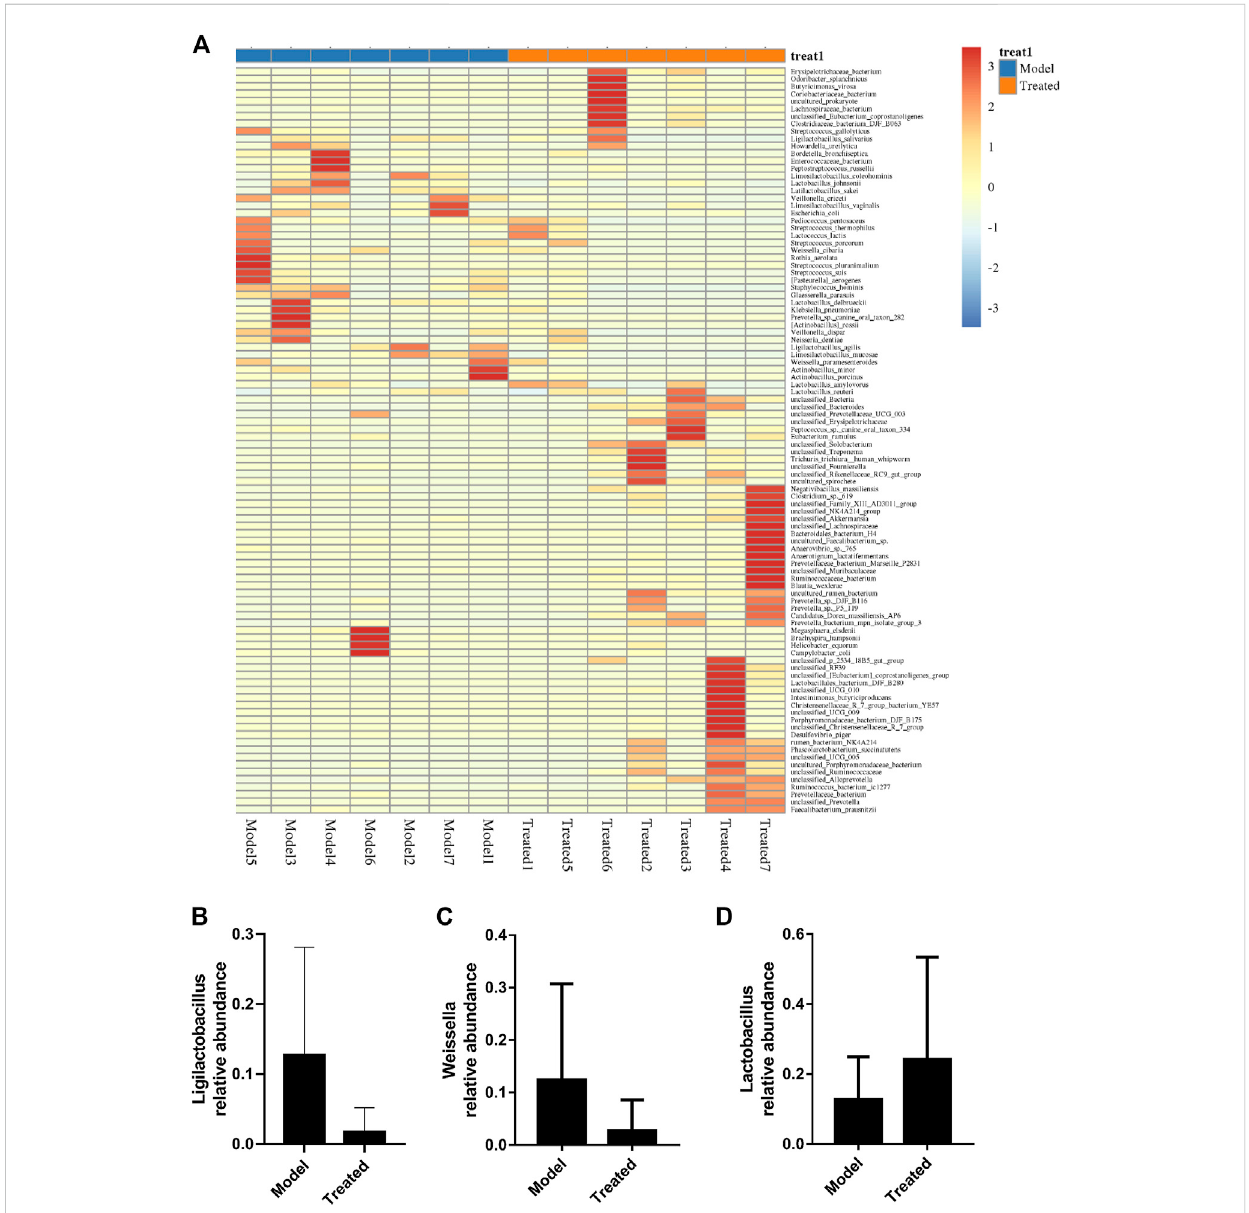
FIGURE 11 Effects of HJ on intestinal microbiota and key microbiota at the species level. (A) Species composition heat map at the genus level for species clustering. The higher the yellow degree was, the lower the relative abundance of the species was; and the higher the red degree was, the higher the relative abundance of the species was. The contents of (B) Ligilactobacillus_agilis, (C) Weissella_cibaria, and (D) Lactobacillus _amylovorus were measured to evaluate the changes of intestinal microbiota. Data are presented as mean ± SD, n =